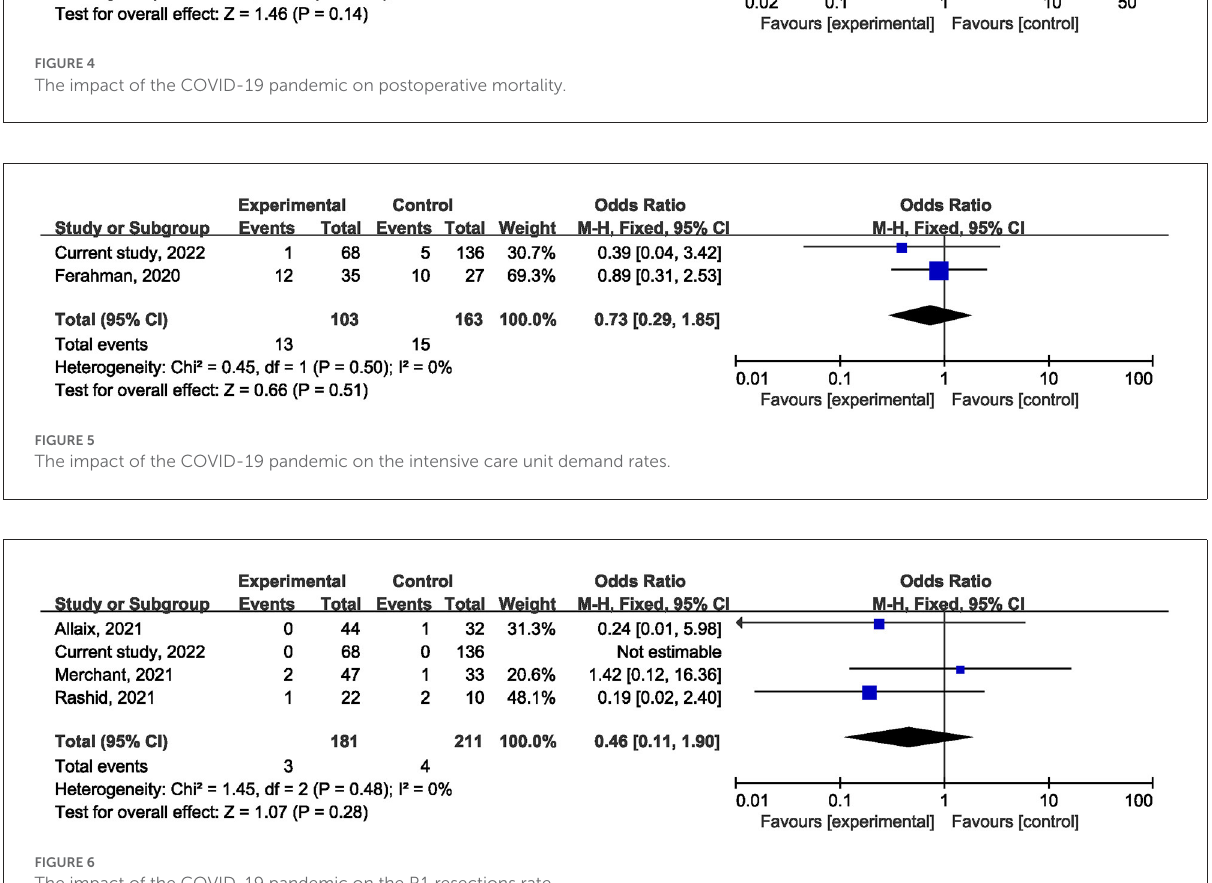
recommend delaying elective colorectal cancer surgery during the